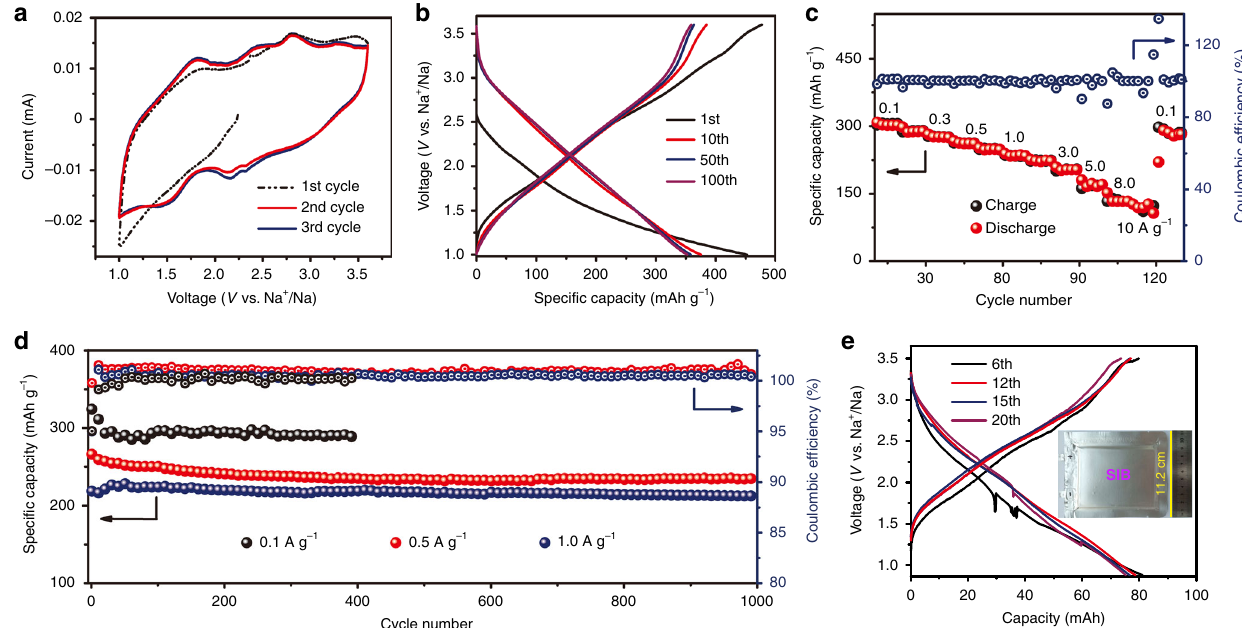
Fig. 5 Electrochemical properties of the TQBQ-COF electrodes between the voltage range from 1.0 V to 3.6 V. a CV curves of the TQBQ-COF electrode at a scan rate of 0.2 mV s − 1 . b Charge – discharge pro fi les of the TQBQ-COF electrode at 0.02 A g − 1 . c The rate performance of the TQBQ-COF electrode from the current density of 0.1 to 10 A g − 1 , then back to 0.1 A g − 1 . d Long cycling stability of TQBQ-COF electrodes at different current densities (0.1, 0.5, and 1.0 A g − 1 ). The capacities are all calculated based on the mass of TQBQ-COF. e The selected charge/discharge curves of pouch-type Na//TQBQ-COF batteries at a current of 50 mA. The capacity is calculated based on the mass of the full